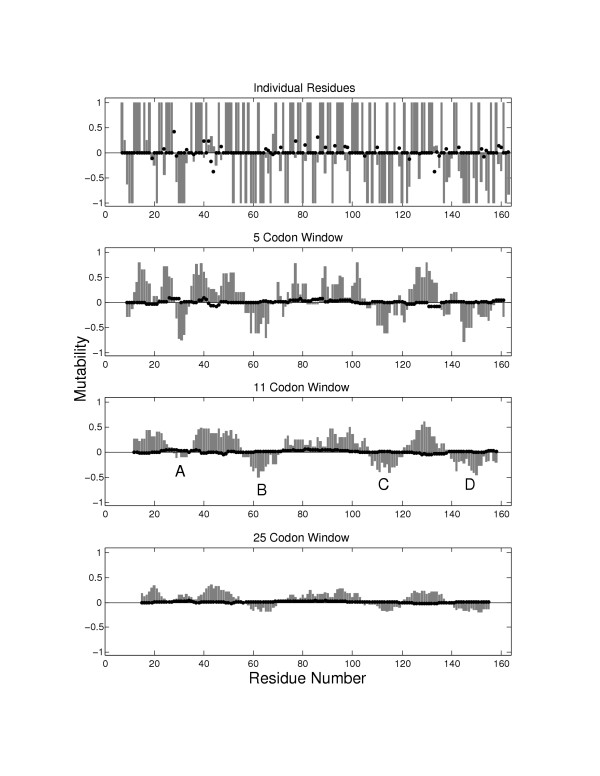
Mutability plots. Mutability plots were determined as described in the text (grey bars). The mutability of individual residues was averaged over a window of 1, 5, 11 or 25 codons. The hypo- or hypermutability was then plotted as a bar in the center of the specified window and the window was shifted downstream one codon at a time. Individual hypomutable regions, designated A, B, C, and D are indicated on the plot for the 11 codon window. For comparison, the difference between mutability calculated by previous methods (5) and mutability as described in this manuscript is also shown (circles).